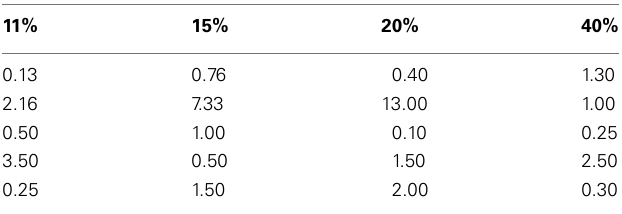
Table 1 | Euro amounts offered by proposers in the computer ultimatum